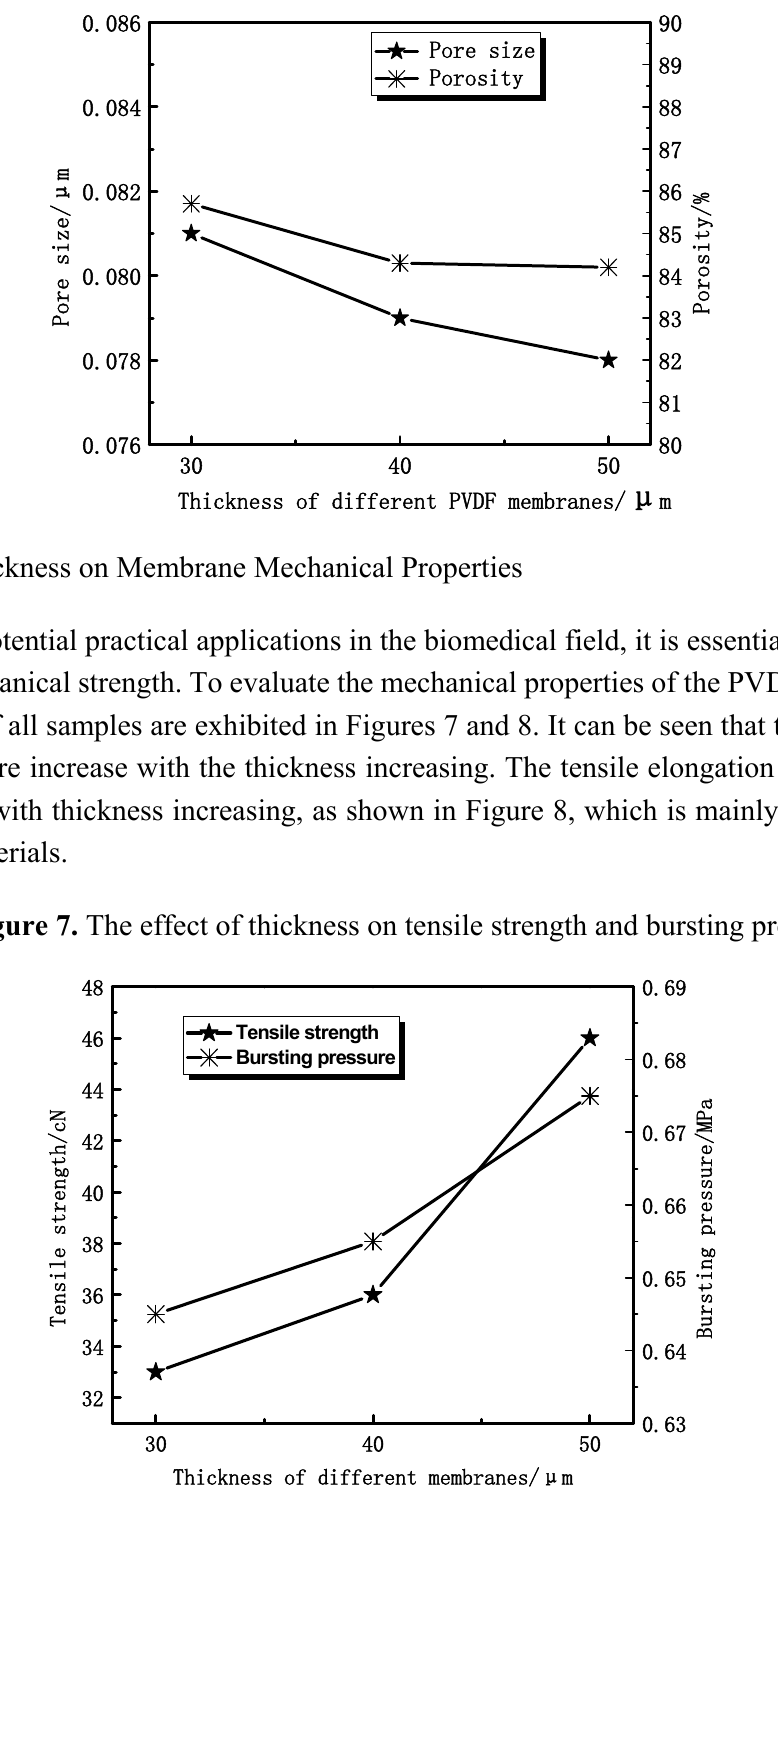
Figure 6. The effect of membrane thickness on the maximum pore size and porosity.